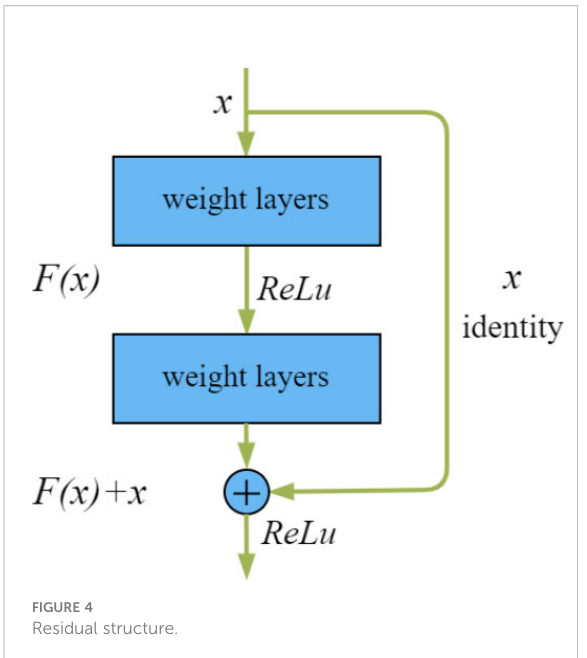
FIGURE 4 Residual